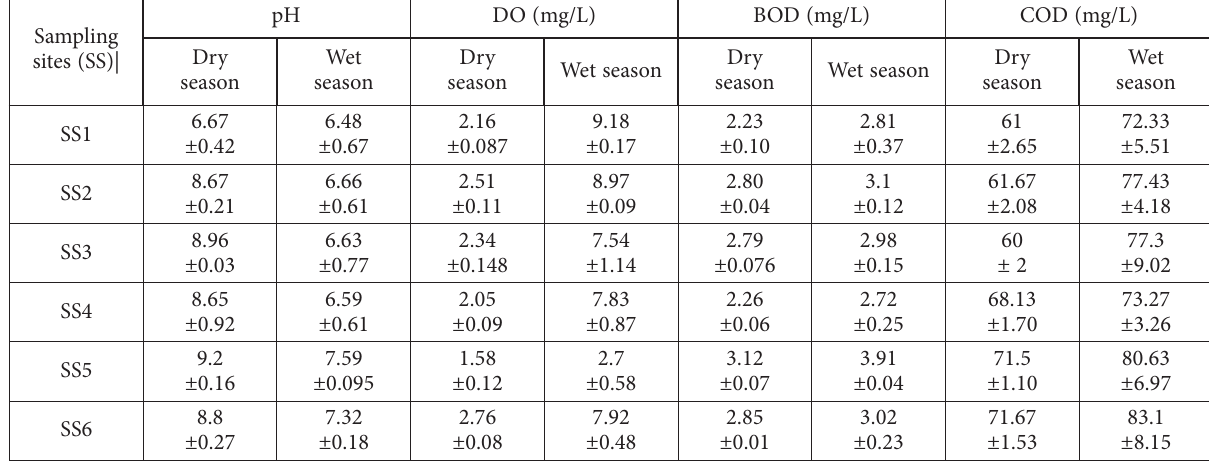
Table 2. Seasonal and temporal variation in chemical properties of ground